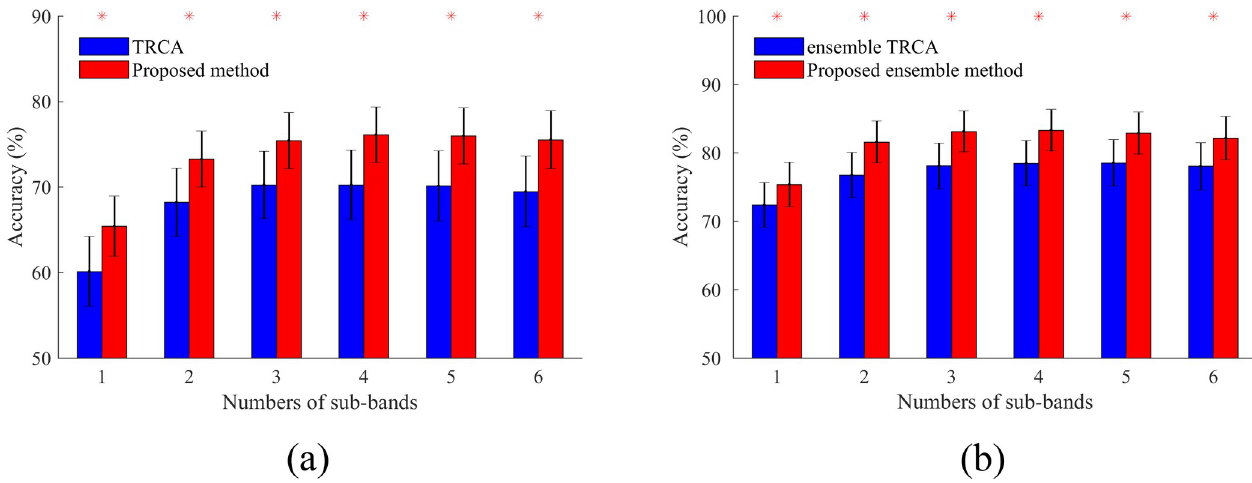
Fig 5. Average accuracies across subjects for different number of sub-bands. (a) Basic TRCA and the proposed method; and (b) ensemble TRCA and the proposed ensemble method. Asterisks show significant differences between the two methods by paired t-tests ( � p < 0.001). Error bars show standard errors.